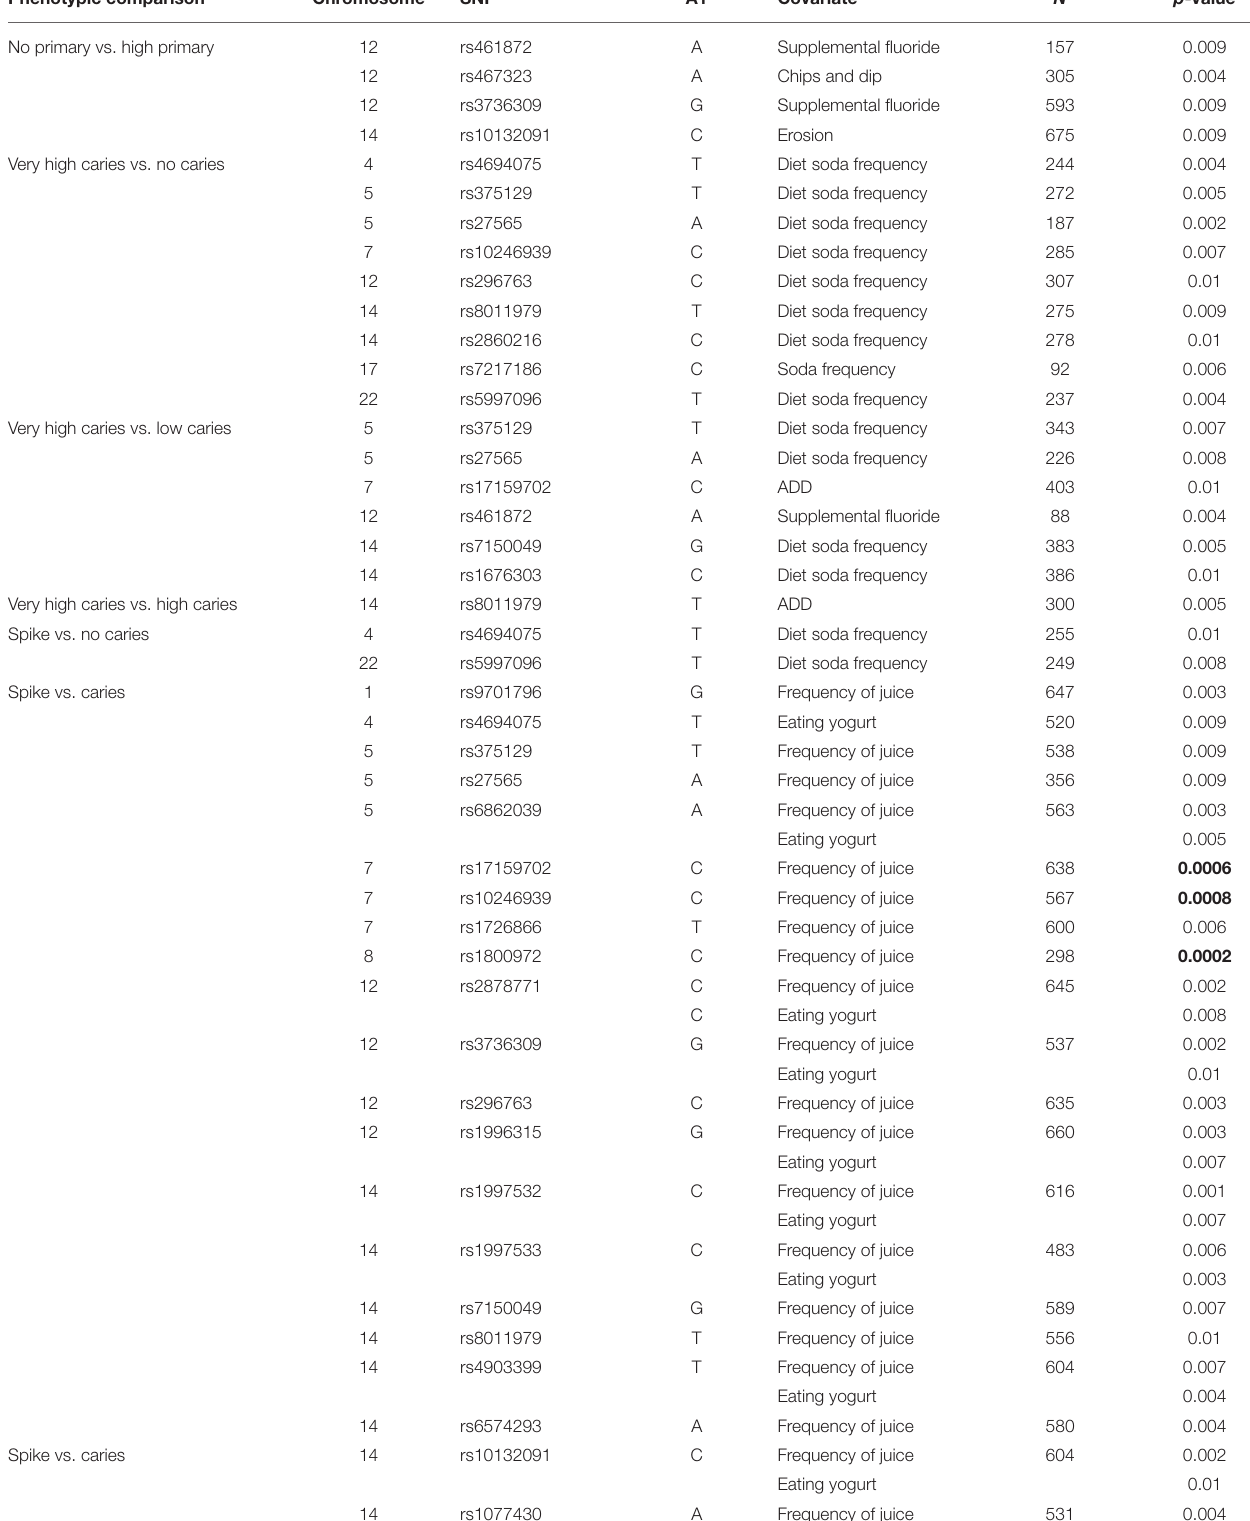
TABLE 3 | Summary of the association